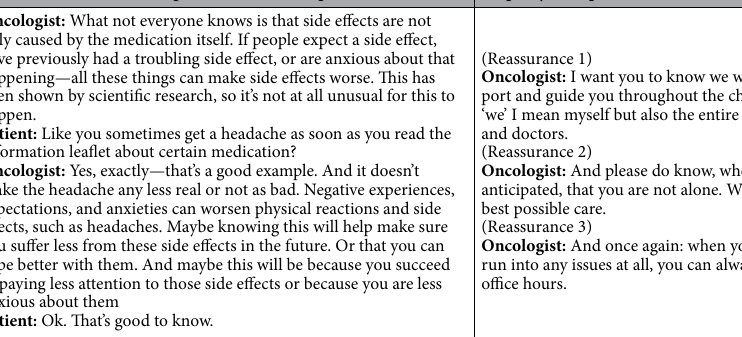
Table 2. Nocebo information and empathy manipulations as used in the video